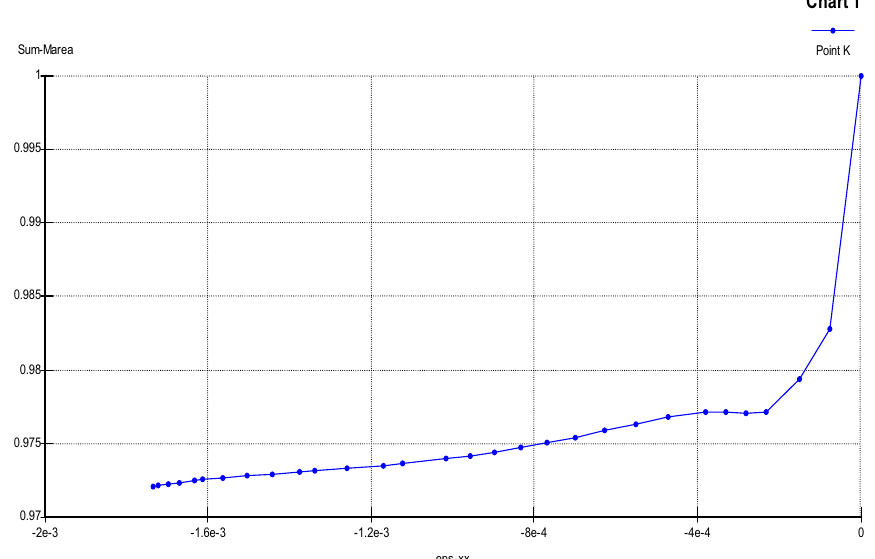
Fig. 12. Load-Displacement Curve for Hormheb tomb (KV57), Sum-M area-eps-xx curve for point